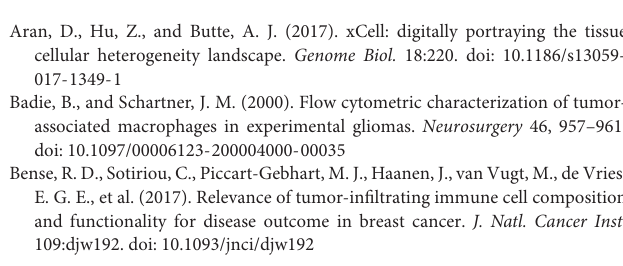
from a two-sided Student’s t -test or Mann-Whitney test. * p < 0.05, ** p < 0.01, *** p < 0.001, **** p < 0.0001. Supplementary Figure 3 | Estimating the infiltrating level of 34 kinds of immune cells in CGGA693 LGG using xCell tool. The heatmap shows the infiltrating levels of immune cells in different subgroup LGG patients in CGGA693 LGG. The number of patients in each subgroup was shown in Figure 1 . P values are inferred from a two-sided Student’s t -test or Mann-Whitney test. * p < 0.05, **textitp < 0.01, *** p < 0.001, **** p < 0.0001. Supplementary Figure 4 | Expression of marker genes for immune cells in CGGA325 LGG. The heatmap shows the expression levels of marker genes for CD4 + T cells, effector CD8 + T cells, NK cells, B cells, T-reg cells, dendritic cells, and macrophages among different subgroup LGGs in CGGA325 LGG. P values are inferred from a two-sided Student’s t -test or Mann-Whitney test. The number of patients in each subgroup was shown in Figure 1 . * p < 0.05, ** p < 0.01, *** p < 0.001, **** p < 0.0001. Supplementary Figure 5 | Expression of marker genes for immune cells in CGGA693 LGG. The heatmap shows the expression levels of marker genes for CD4 + T cells, effector CD8 + T cells, NK cells, B cells, T-reg cells, dendritic cells, and macrophages among different subgroup LGGs in CGGA693 LGG. P values are inferred from a two-sided Student’s t -test or Mann-Whitney test. The number of patients in each subgroup was shown in Figure 1 . * p < 0.05, ** p < 0.01, *** p < 0.001, **** p < 0.0001. Supplementary Figure 6 | Differentially expressed immune checkpoint genes among different subgroups in CGGA325 and CGGA693 LGG. The heatmap shows the expression levels of immune-related genes on chromosome 1p/19q in different subgroups of LGG patients in CGGA325 LGG (A) and CGGA693 LGG (B) . P values are inferred from a two-sided Student’s t -test or Mann-Whitney test. The number of patients in each subgroup was shown in Figure 1 . * p < 0.05, ** p < 0.01, *** p < 0.001,**** p < 0.0001. Supplementary Figure 7 | Expression of immune-related genes on chromosome 1p/19q in CGGA325 and CGGA693 LGG. Heatmap of differentially expressed immune-related genes in LGG patients in different subgroups of patients in CGGA325 LGG (A) and CGGA693 LGG (B) . Supplementary Figure 8 | The expression of CSF1, TGFB1, and JAK1 in different subgroups classified by IDH mutation and 1p/19q codel status in CGGA325 LGG and CGGA693 LGG. The mean mRNA expression was indicated by red lines. P values are inferred from a two-sided Student’s t -test or Mann-Whitney test. (* p < 0.05, ** p < 0.01, *** p < 0.001, **** p < 0.0001). Supplementary Table 1 | List of biological processes negatively associated with IDH mutation in LGG datasets. Supplementary Table 2 | List of biological processes negatively associated with IDH mutation in 1p/19q non-codeletion LGGs of all three LGG datasets. Supplementary Table 3 | List of biological processes negatively associated with 1p/19q codeletion (Codel) of all three LGG datasets. Supplementary Table 4 | List of biological processes negatively associated with 1p/19q codeletion in muIDH LGGs of all three LGG datasets. Supplementary Table 5 | List of immune-related genes mapped on chromosome 1p and